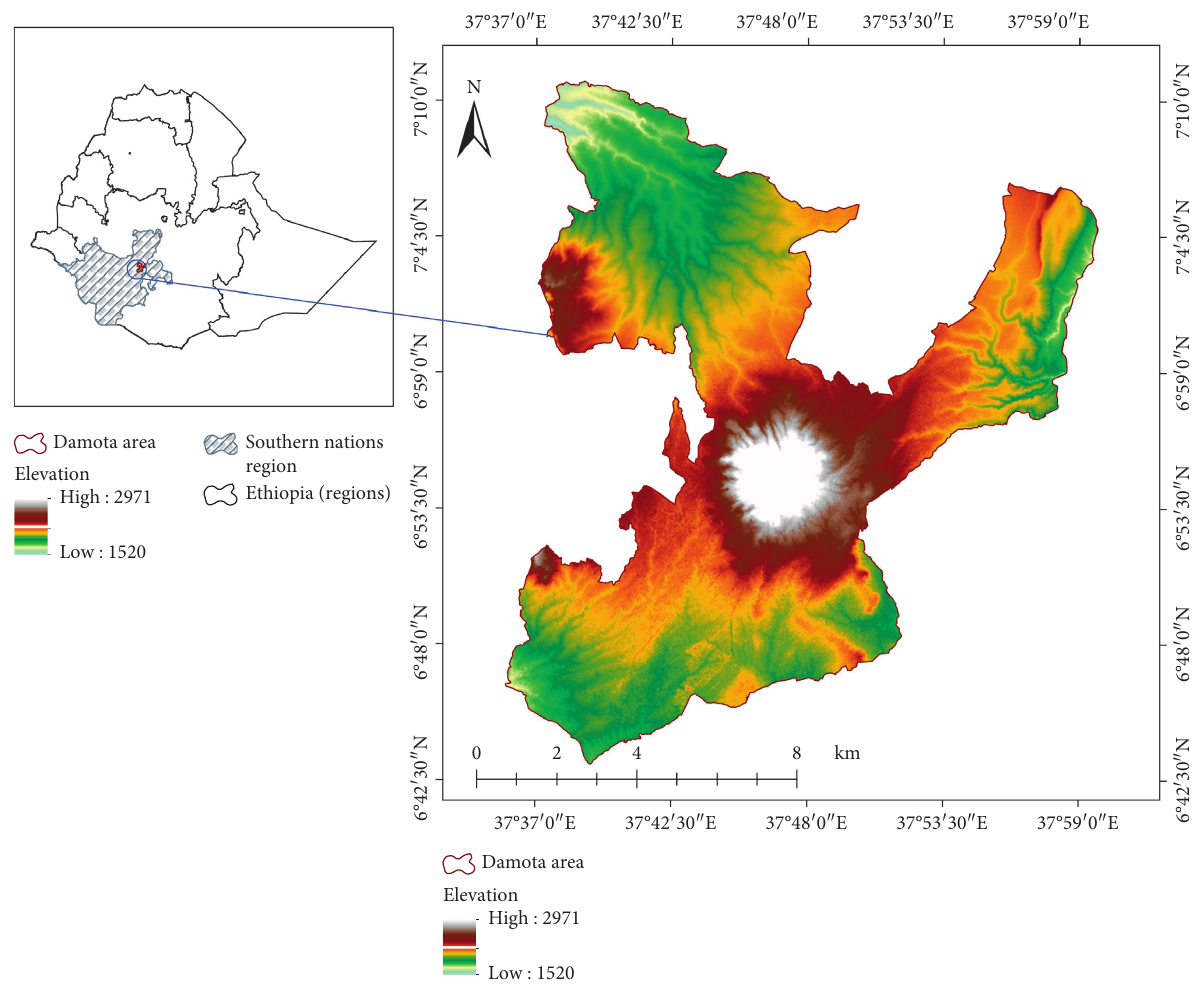
Figure 1: Location map of the study area (Damota area), Southern Ethiopia.